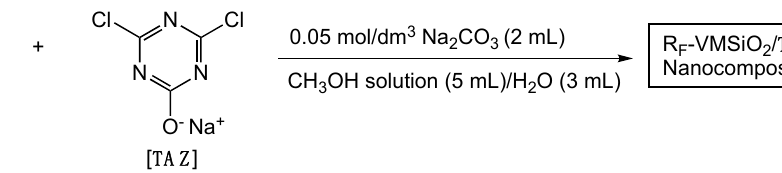
Table 1. Synthesis of R F -VMSiO 2 /TAZ